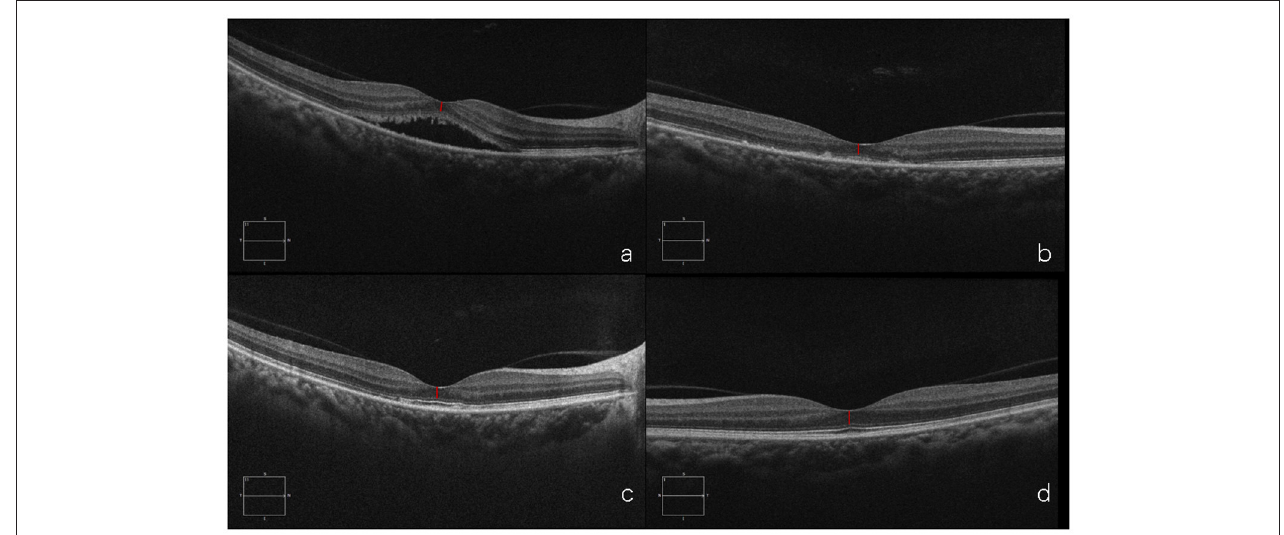
FIGURE 9 | Optical coherence tomography (OCT) of the diseased eye before PDT (a) . 1 month after PDT (b) . 6 months after PDT (c). and of the fellow healthy eye (d)